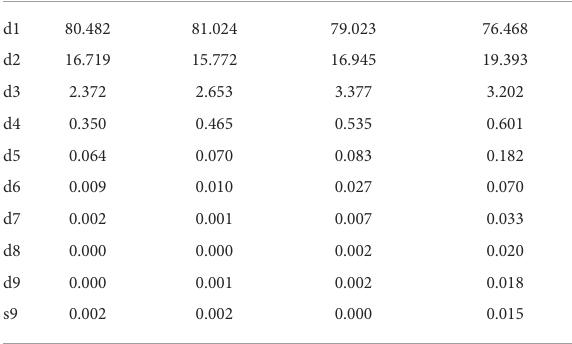
TABLE 5 Energy for Daubechies wavelet coefficients (d1-d9) are calculated in percentages, s9 is the Maximum overlap discrete wavelet transform scaling